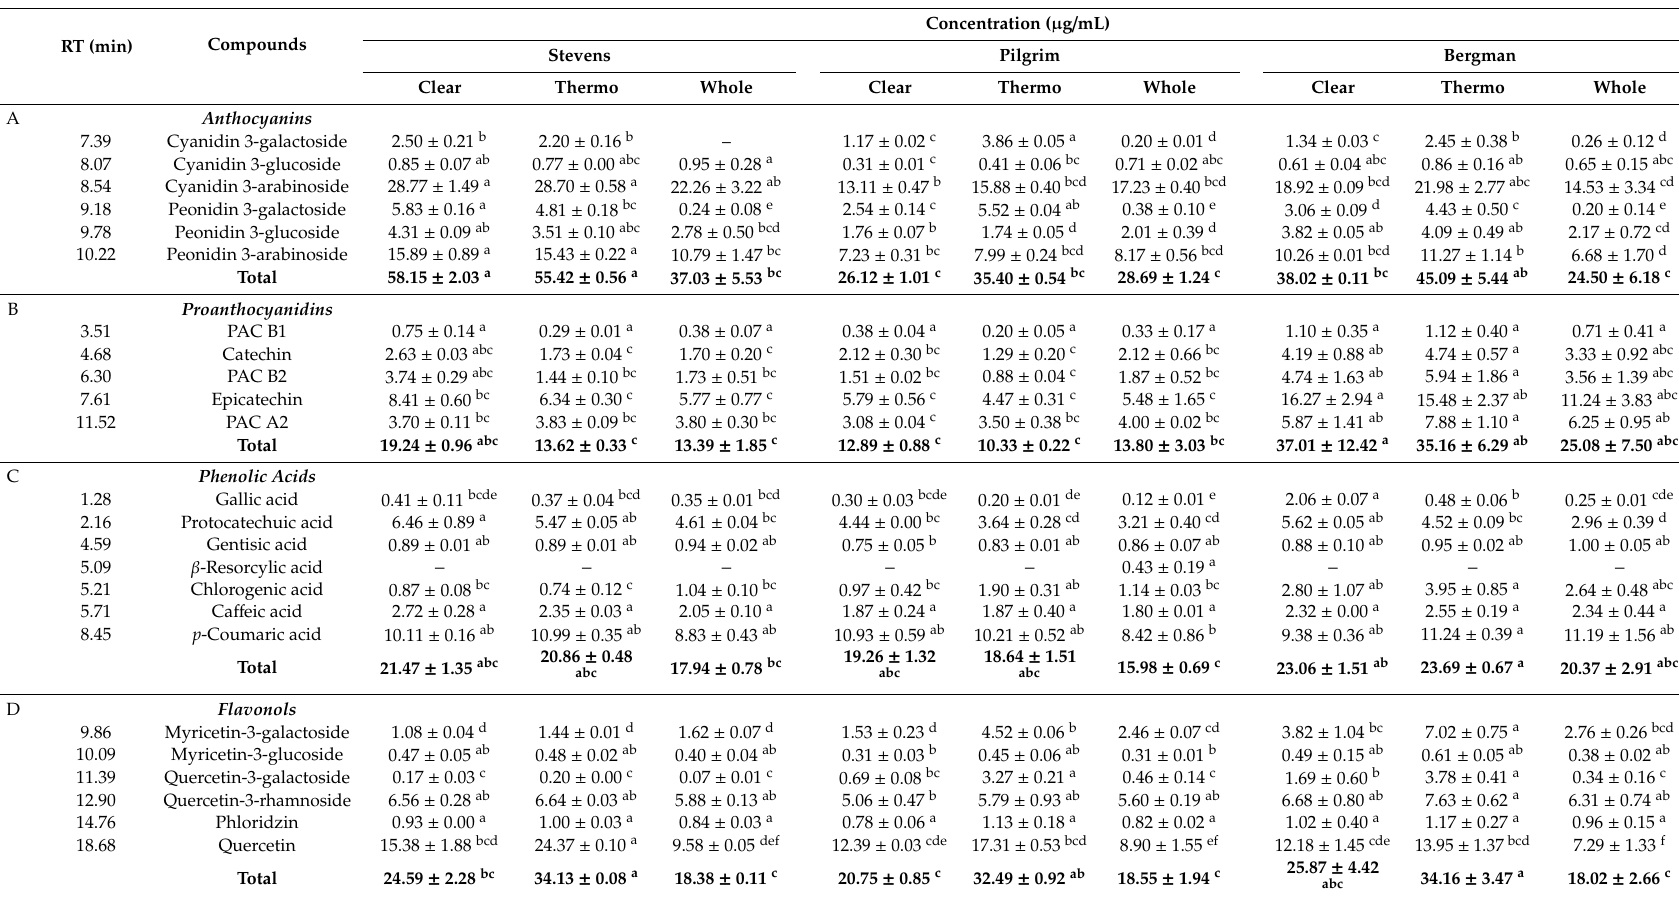
Table 2. The concentration of phenolic compounds detected in cranberry wines by HPLC (high-performance liquid chromatography) (anthocyanins) and LC-MS / MS (liquid chromatography technique coupled with tandem mass spectrometry) (proanthocyanins, phenolic acids and flavonols). Concentration ( µ g / mL) RT (min) Compounds Stevens Pilgrim Bergman Clear Thermo Whole Clear Thermo Whole Clear Thermo